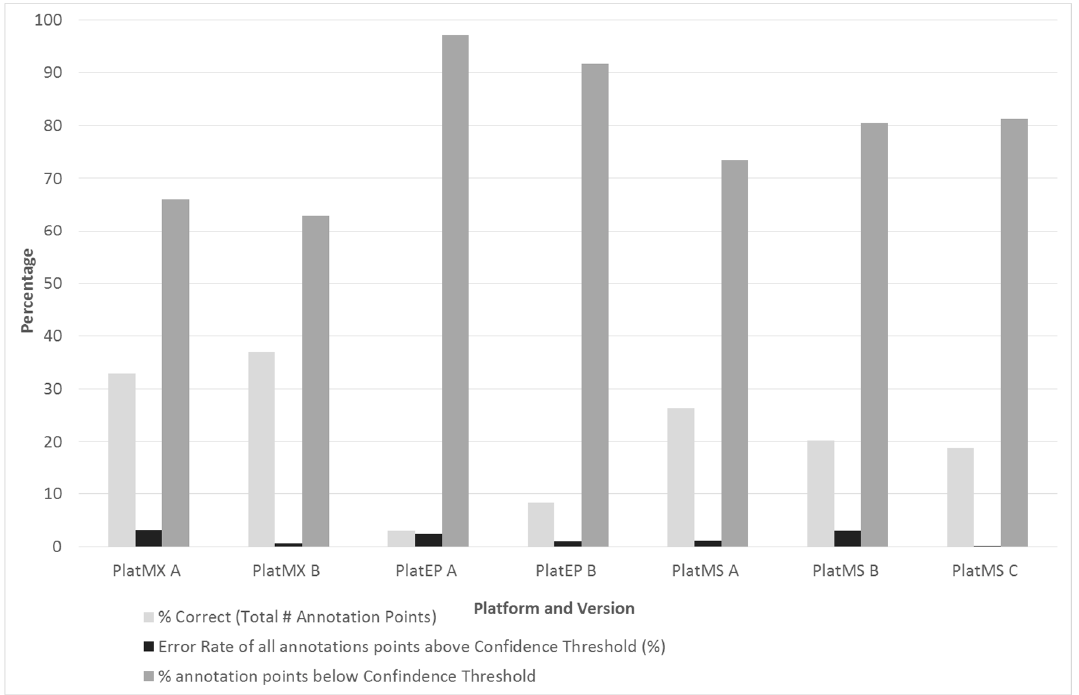
Figure 4. Percentage of the total number of annotation points per platform correctly identified (pale grey) by the software; percentage of the number of annotation points identified by the software (all points above the confidence threshold) that were incorrect/errors (black); and % of the total number of annotations points below the confidence threshold (dark grey). Table 3. Number of annotation for species/labels identified incorrectly by classifier alongside the correct species/label. [#: number of].